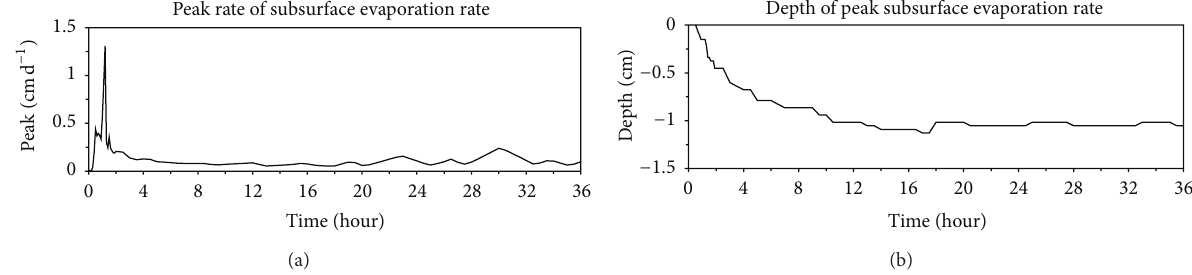
Figure 6: Temporal changes in peaks of the subsurface evaporation rate (a) and its locations (b) in the subsurface evaporation rate profile.